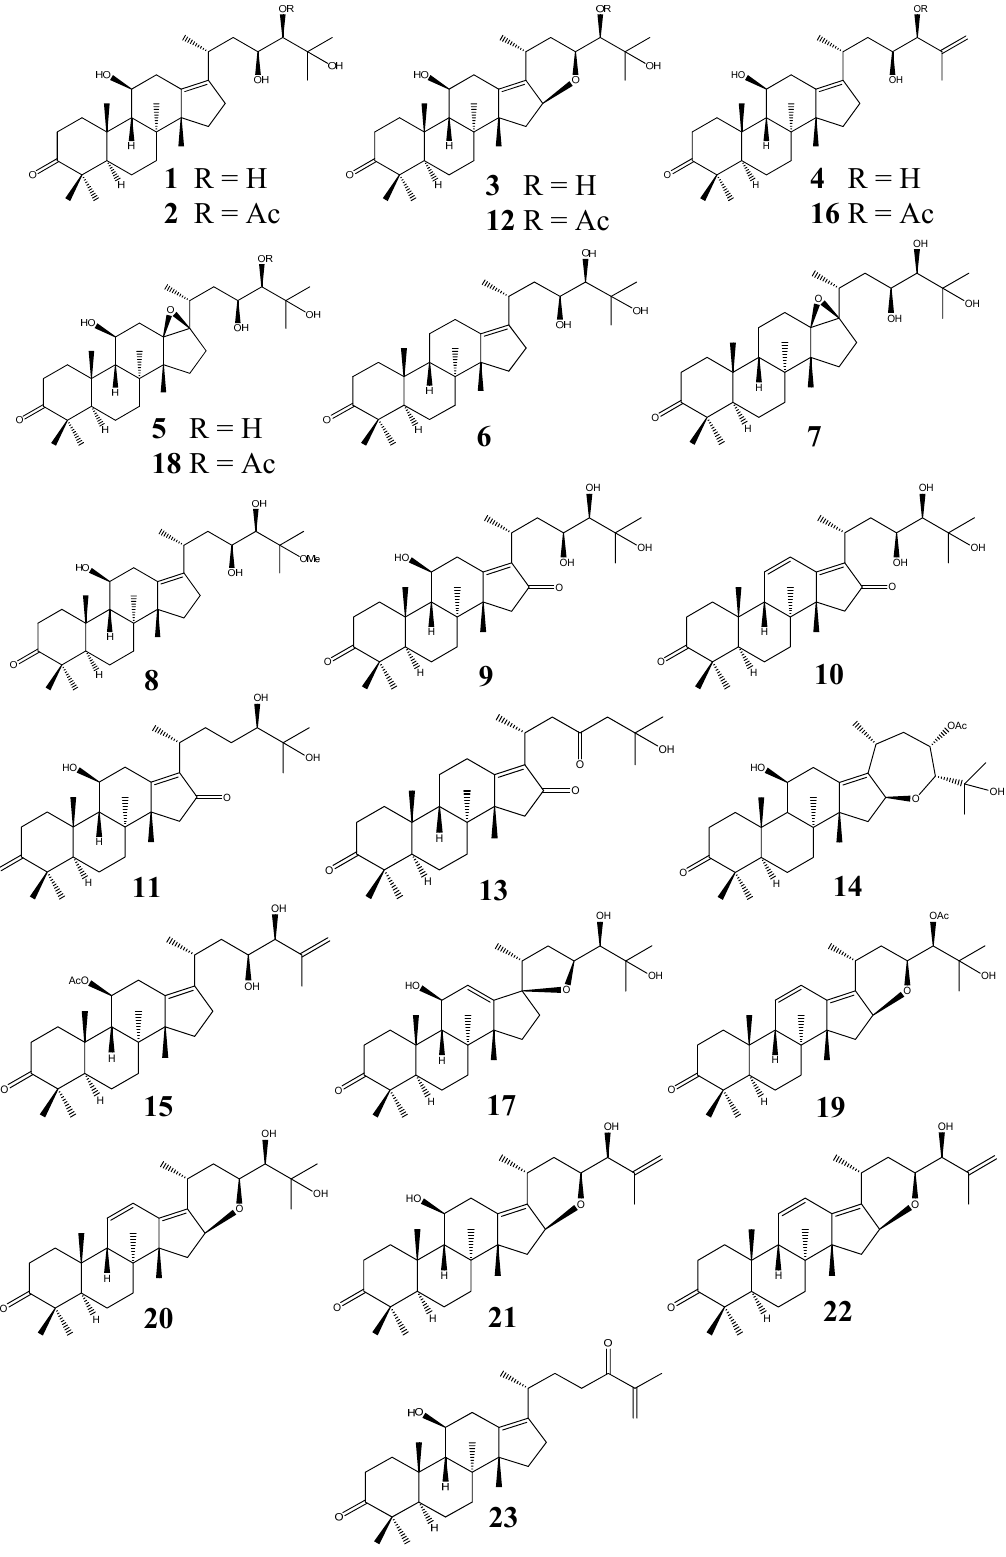
Figure 2. Structures of the alisol A series of